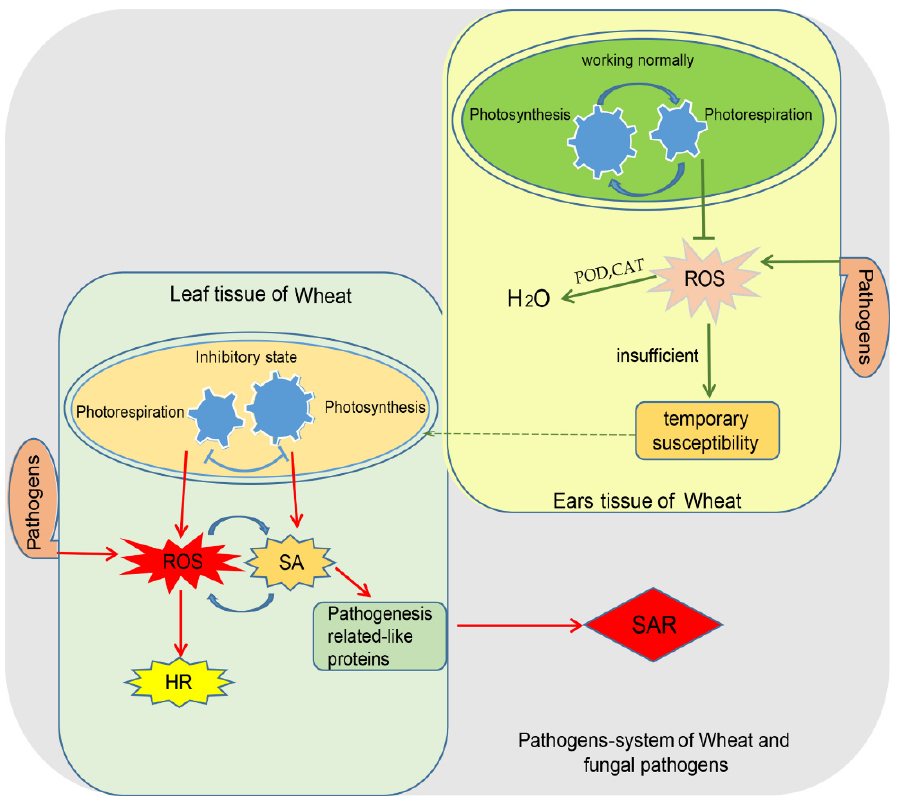
Figure 1. Hypothesized model of photosynthesis involving information concerning resistance to wheat source and sink diseases in the early stages of pathogen invasion.